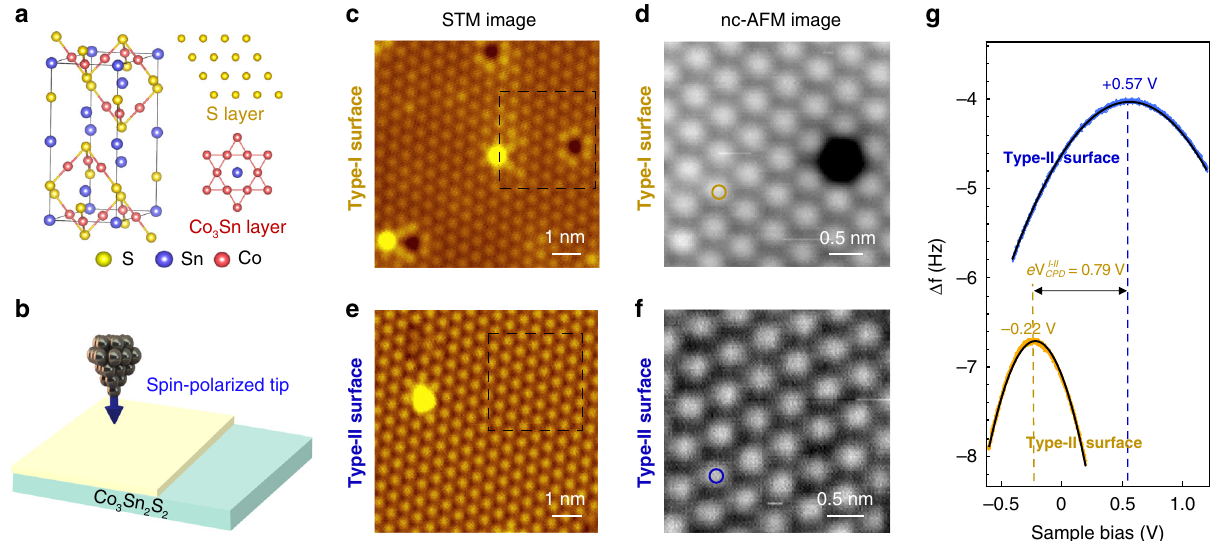
Fig. 1 Identi fi cation of S-surface of Co 3 Sn 2 S 2 using nc-AFM/STM. a Atomic structure of Co 3 Sn 2 S 2 . b Schematic of spin-polarized STM measurements. c and e STM images on Type-I and Type-II surfaces, respectively. d and f Zoomed-in nc-AFM images of ( a ) and ( c ) marked by black squares, respectively. g Δ f ( V ) curves on the orange and blue circles in d and f . The maxima of the Δ f(V) parabolas are located at − 0.22 V and + 0.57 V for Type-I and Type-II surfaces, respectively. The work function difference between the two surfaces is 0.79 eV (refer to Supplementary Fig. 1 for more information). (STM scanning parameters: bias: V s = − 400 mV, setpoint: I t = 10 pA); AFM scanning parameters: amplitude = 100 pm, frequency shift Δ f = − 10 Hz for d and − 40 Hz for f